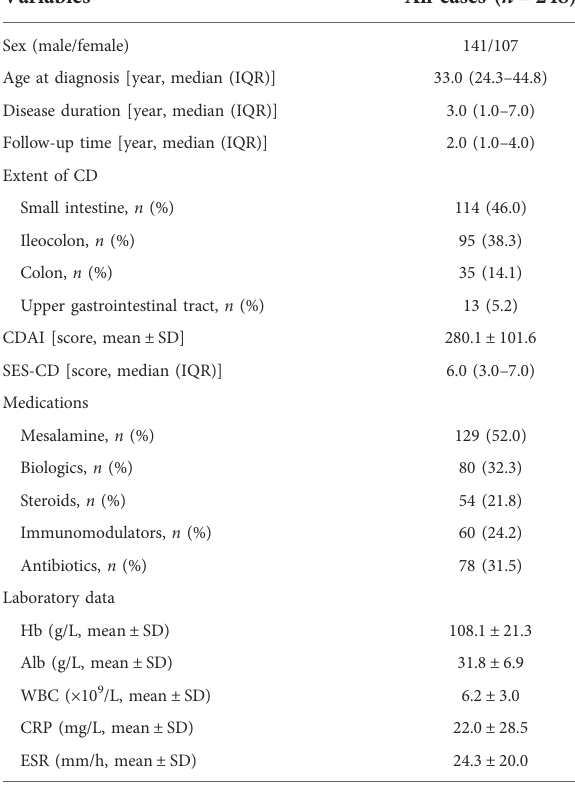
TABLE 1 Main baseline characteristics of